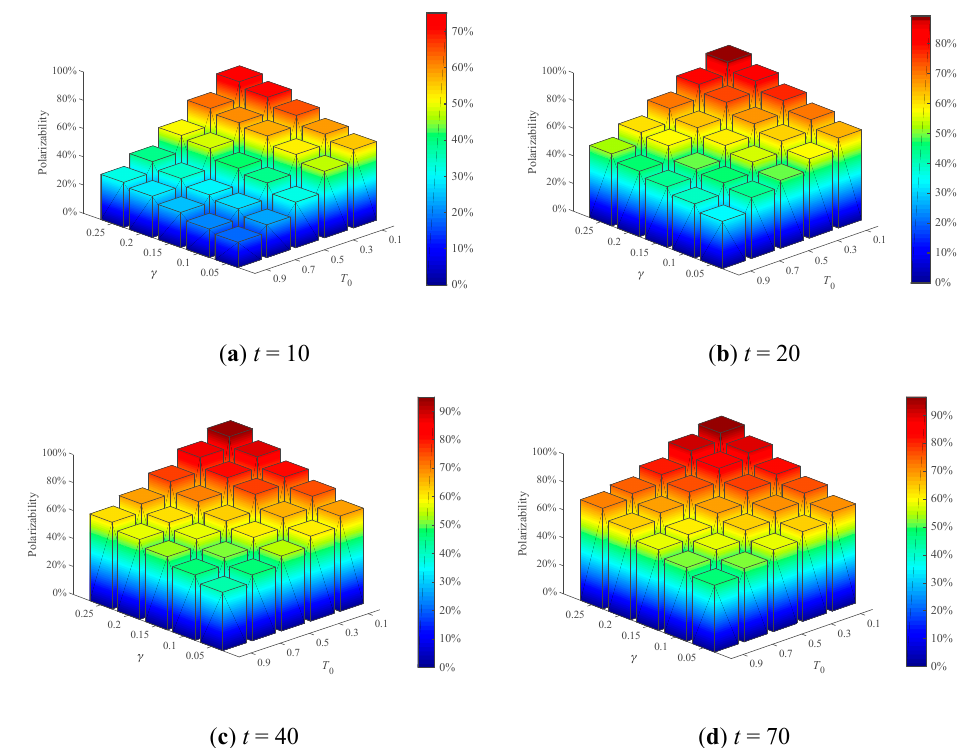
Figure 13. Comparison of different T 0 and γ